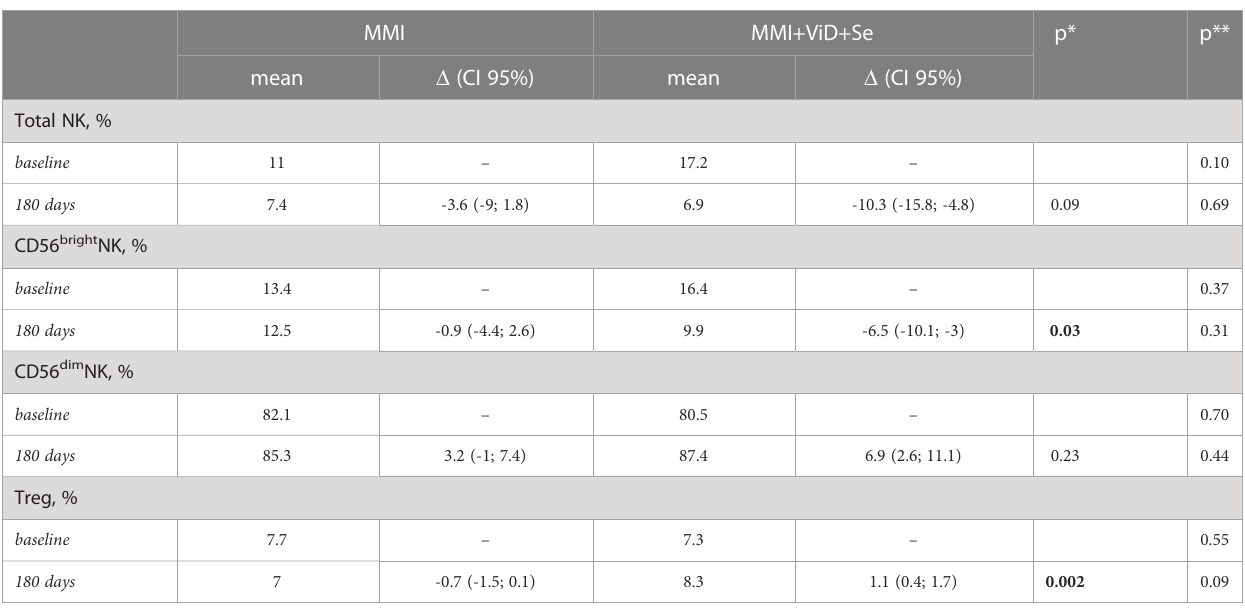
TABLE 2 Temporal changes of natural killer and T regulatory cells percentages from baseline to 180